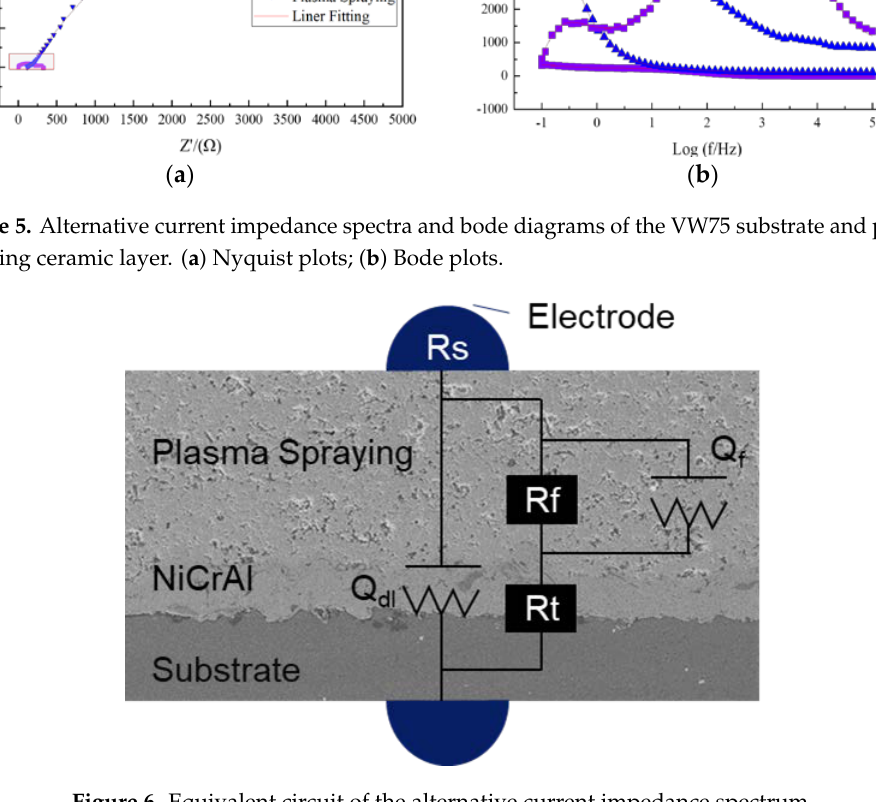
Figure 6. Equivalent circuit of the alternative current impedance spectrum. Table 9. Fitting results of the equivalent circuit of the alternative current impedance spectra of the substrate and plasma spraying coating.